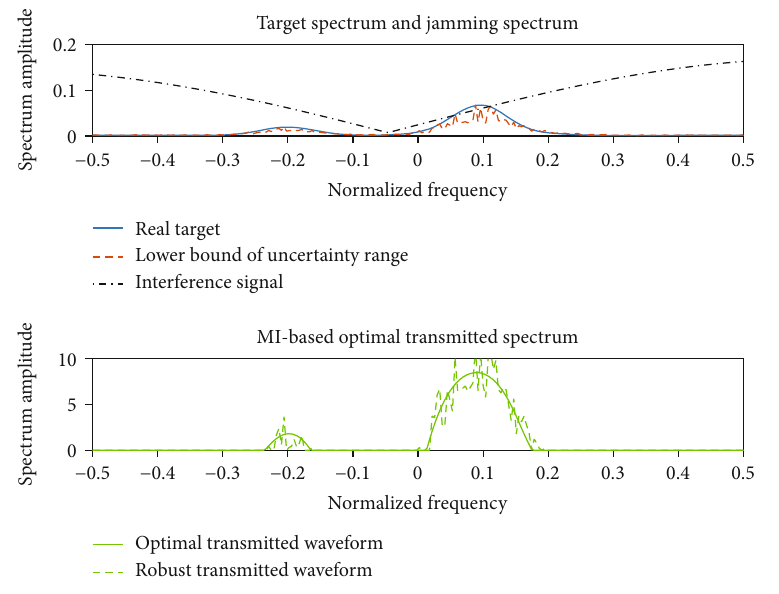
Figure 5: Waveform spectrum results of multiple targets.